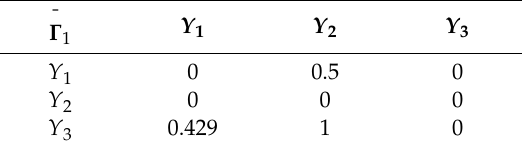
Table 13. The normalized rejoice matrix Γ 1 .